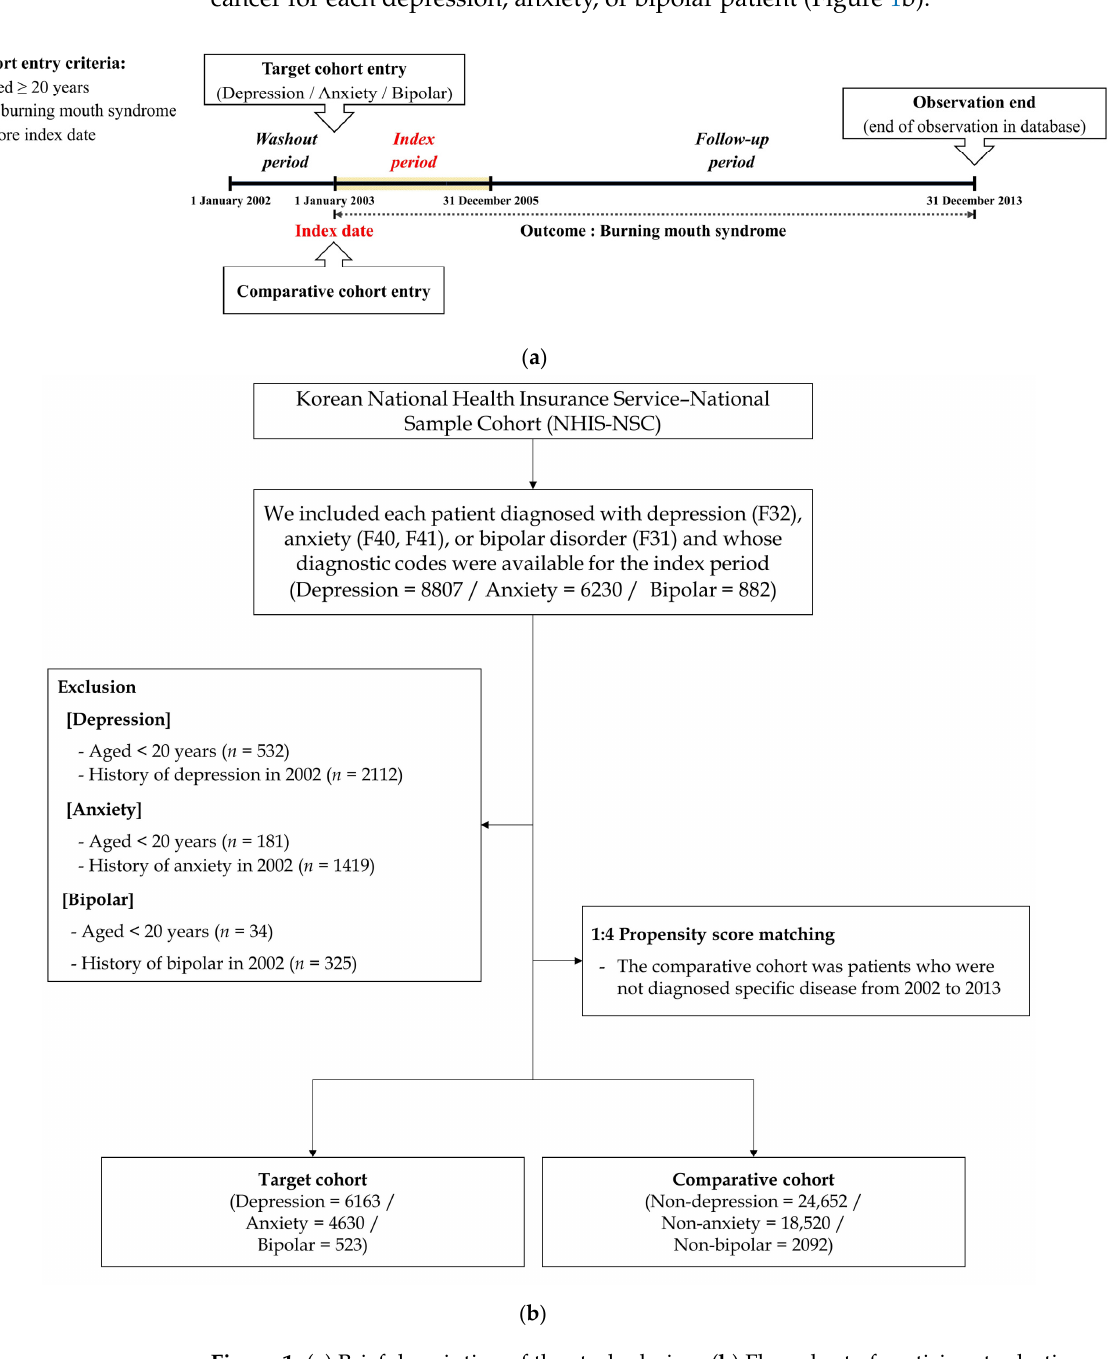
Figure 1. ( a ) Brief description of the study design. ( b ) Flow chart of participant selection. Age, sex, residence, household income, and comorbidities were considered inde- pendent variables. Thus, we controlled for these variables between the two groups in the main analysis, using propensity score matching. Specifically, we obtained information on the comorbidities of each individual and categorized the comorbidities using the Charlson comorbidity index (CCI). It is well-known that comorbidities could influence the devel- opment of BMS. Thus, to accurately investigate the effect of affective disorders on the risk of BMS, we controlled for comorbidities using CCI, which is widely used in claims data studies. The CCI is a weighted index used for predicting the risk of death within 1 year of hospitalization for patients with specific comorbid conditions (overall, 19 conditions were included in the index). All independent variables were classified as follows: age (<45, 45– 64, >64 years), sex (male and female), residence (Seoul, the largest metropolitan region in South Korea; second area: other metropolitan cities in South Korea; and third area: small cities and rural areas), household income (low: ≤ 30%, middle: 30.1–69.9%, and high: ≥ 70% of the median), and comorbidity statuses (CCI: 0, 1, ≥ 2). A BMS event was the primary endpoint during the follow-up period, and if patients had no events until the final period of this database, we censored this time point (Table 1).